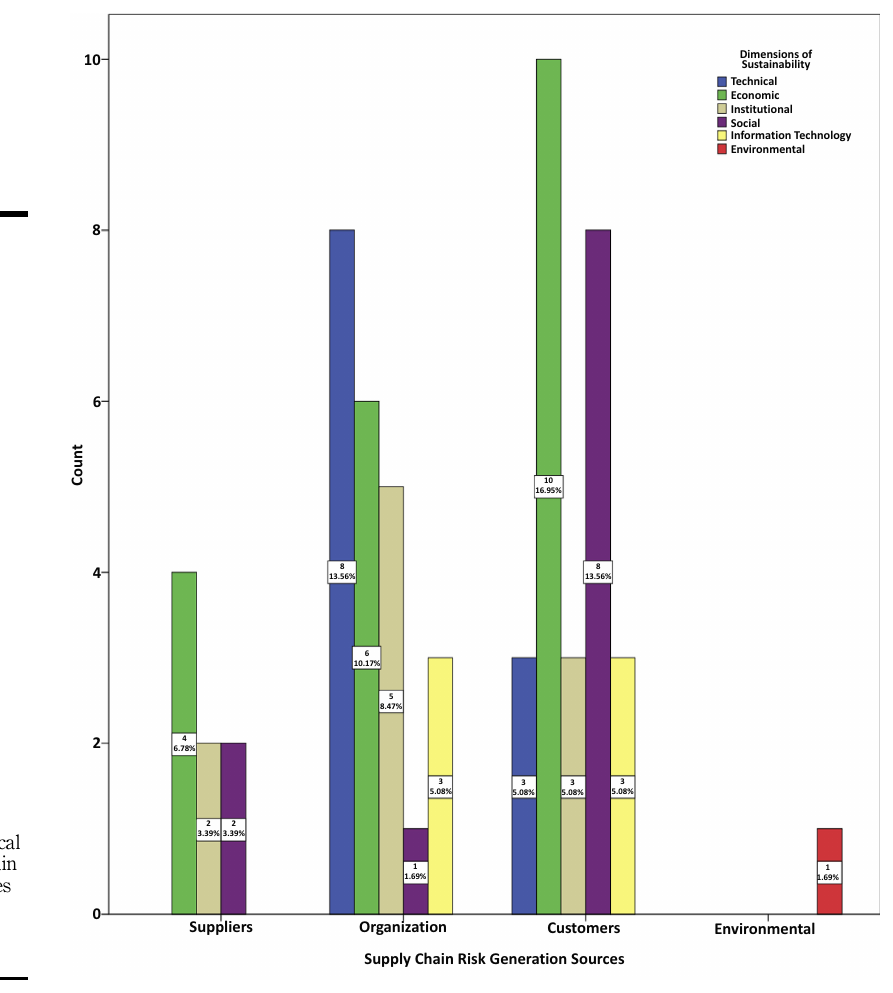
Figure 9. Distribution of critical risks by supply chain production resources and sustainable development